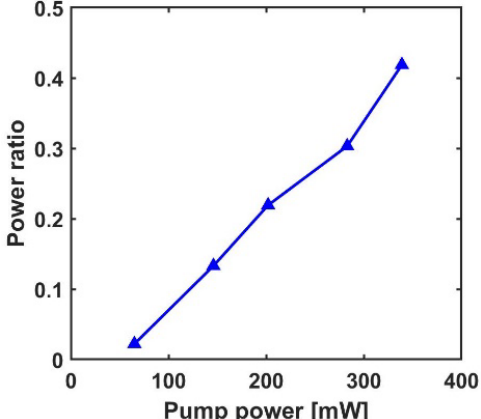
Figure 3. The variation of the power ratio of in-band ASE to signal power with the pump power. The seed power is 41 mW. The in-band ASE is calculated within the ranges of 972~975.89 nm and 976.67~983 nm, and the signal power is calculated within the range of 975.89~976.67 nm.